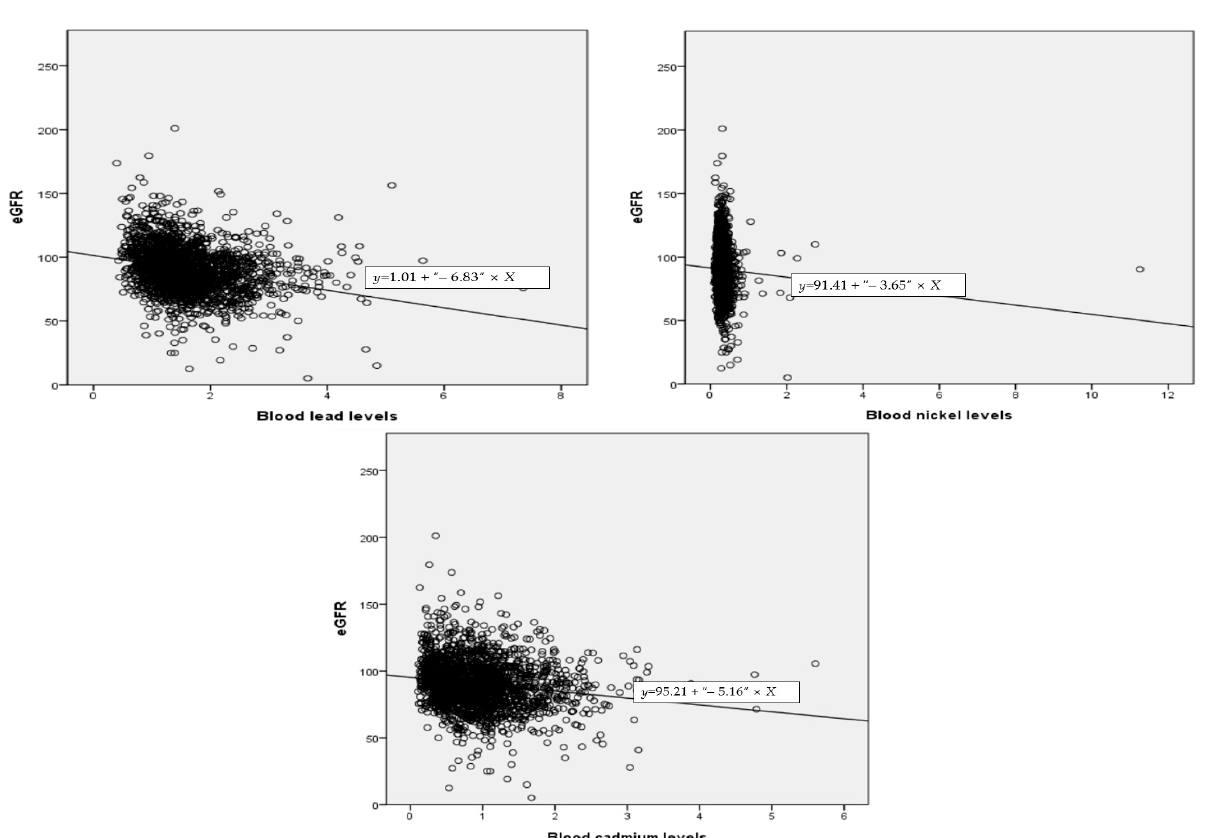
Abbreviation: eGFR, estimated glomerular filtration rate.